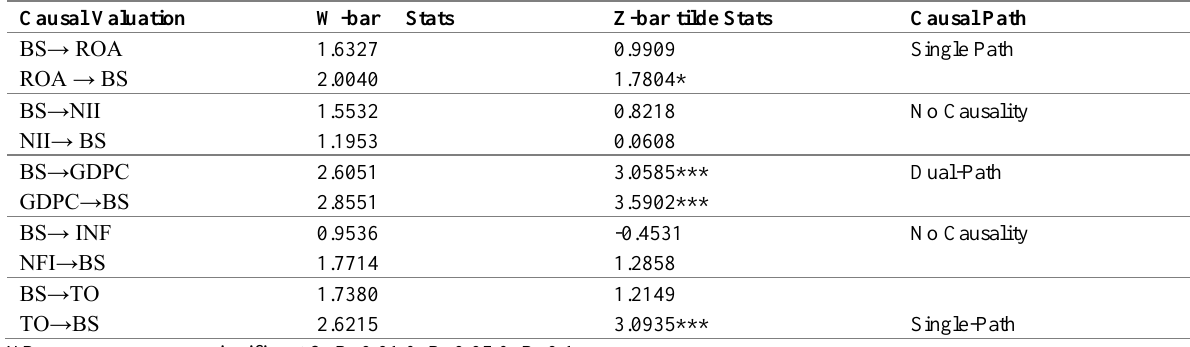
Table 7: Results of